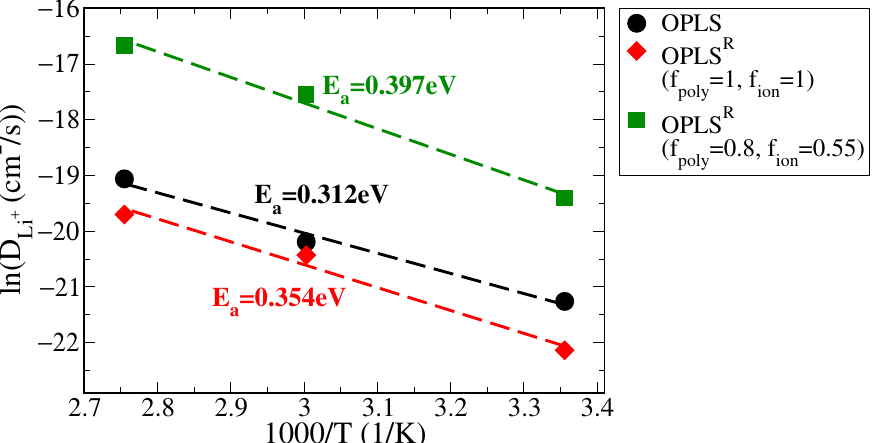
Figure 8. Arrhenius plot of D Li + versus inverted temperature for PEO/LiTFSI SPE systems in OPLS, full-charged OPLS R and charge-rescaled OPLS R force fields, along with the corresponding Li + diffusion activation energy E a values.